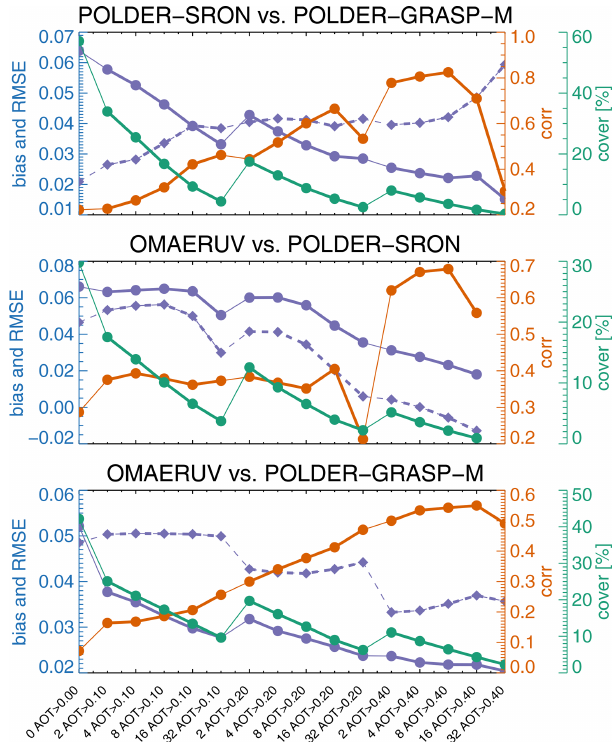
Figure 13. Intercomparison of SSA satellite products after multi- year averaging, as a function of minimum AOD and number of col- located observations (thicker lines group cases with the same mini- mum AOD but increasing number of observations). The bias uses a dashed line and the RMSE a solid line. Cover is defined as fraction of surface area covered by data. FL-MOC is not present due to the scarcity of observations. The data were collocated within